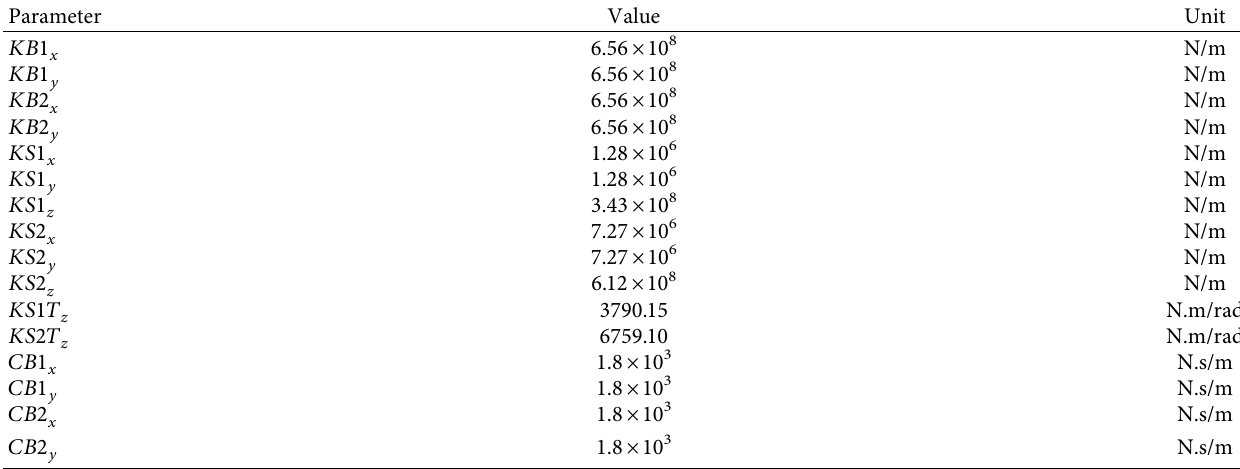
Table 4: Physical parameters of the rotor-bearing system.